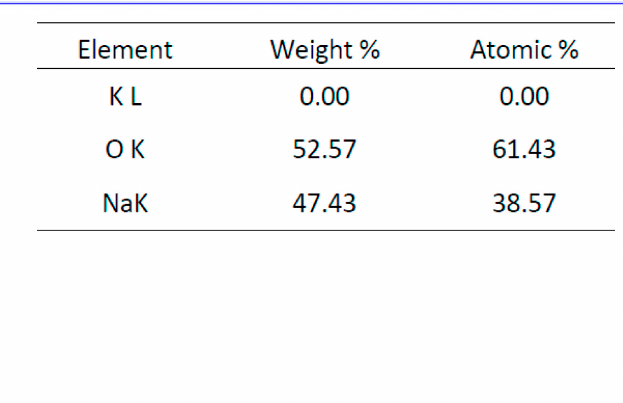
Figure 2. EDX spectrum of solid of